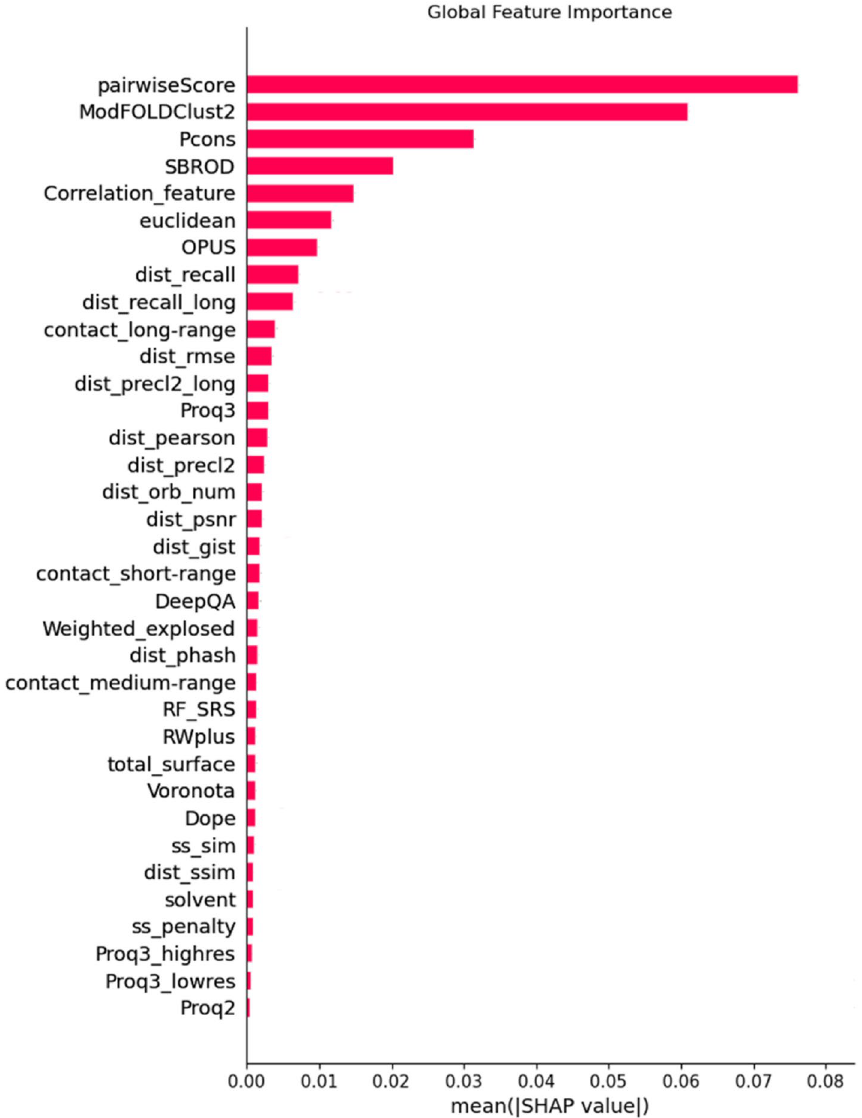
Figure 2. A bar plot of the average SHAP values of the